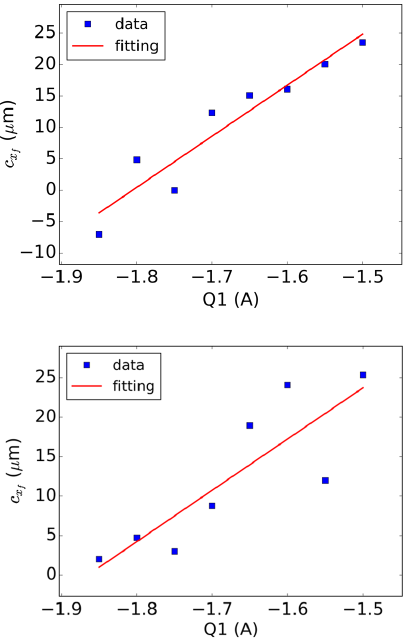
FIG. 12. Typical fits in the horizontal plane with an initial rms position jitter of 10 μ m (top) and rms pointing jitter of 1 μ rad (bottom).